Question: Provide a publication-style caption for this figure.
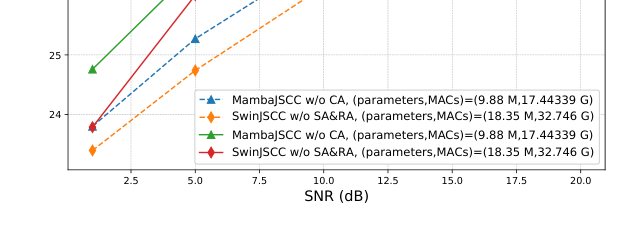
Answer: The PSNR performance of MambaJSCC w/o CA and SwinJSCC w/o SA&RA versus SNR under the AWGN and the Rayleigh fading channels. Nm and Ns are set to 6.